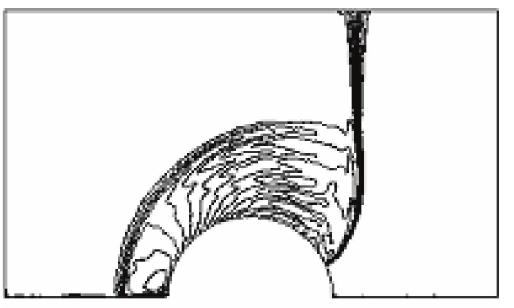
Figure 2: Isopycnics showing the shock diffraction over the sphere.